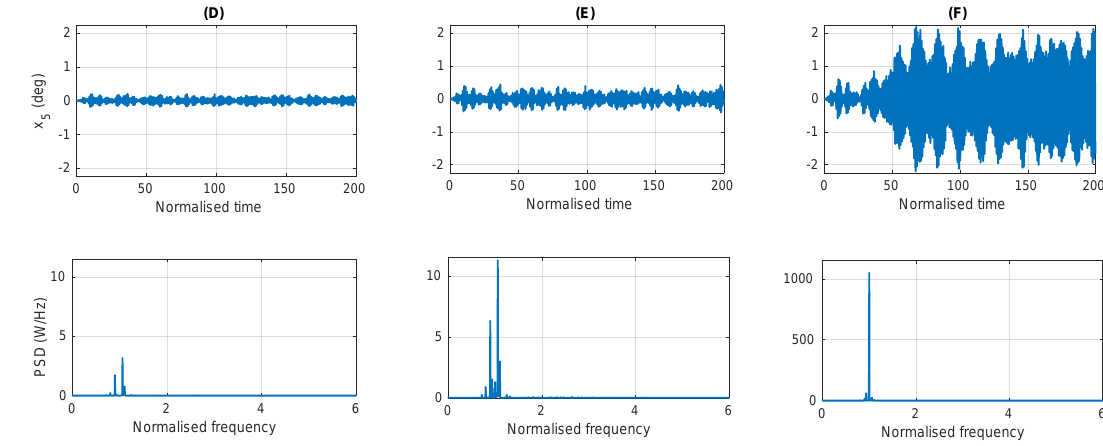
Figure 13. The pitch displacement time series and resulting PSD for the points (D) D, (E) E and (F) F in Figure